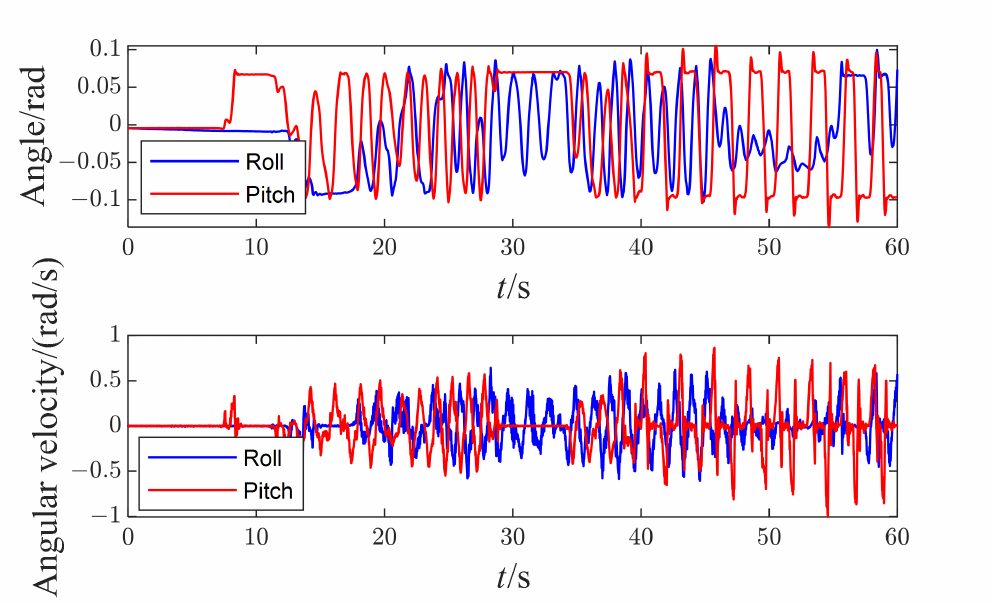
Figure 10. The measured orientation and angular velocity of the right foot.